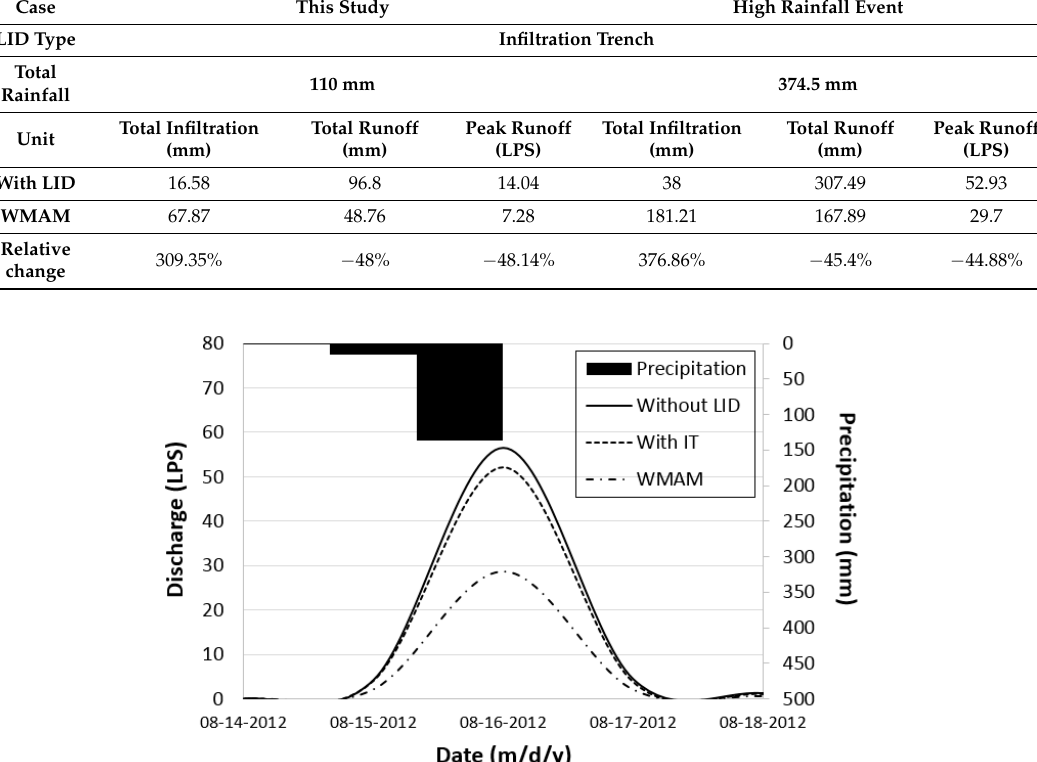
Table 9. Comparison of the WMAM results to different LID